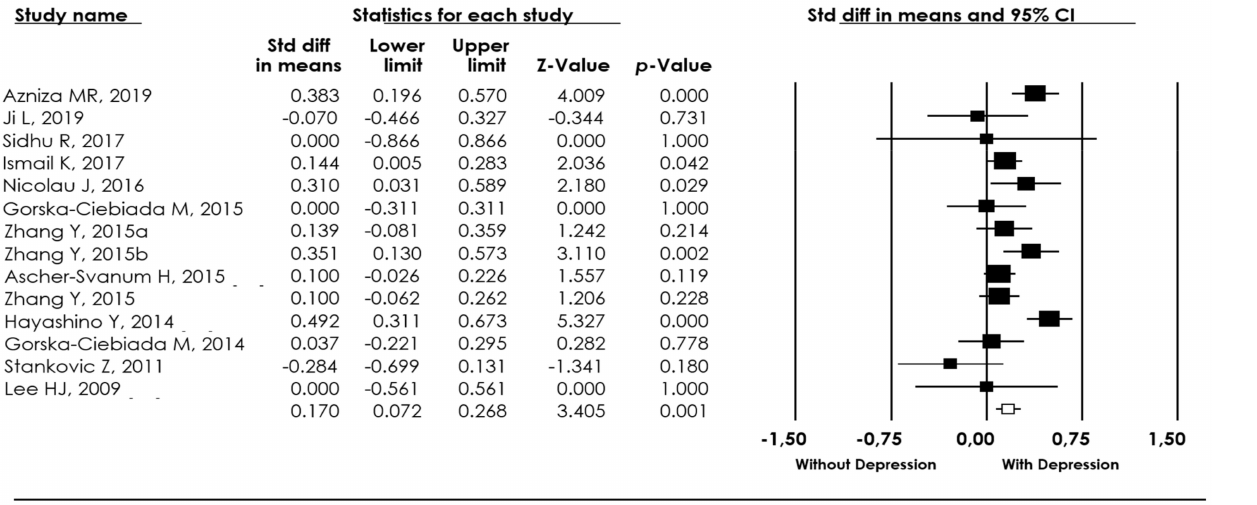
Figure 5. Forest plot of the meta-analysis for HbA1c levels in individuals with/without type 2 diabetes mellitus (T2DM)-related complication analysis